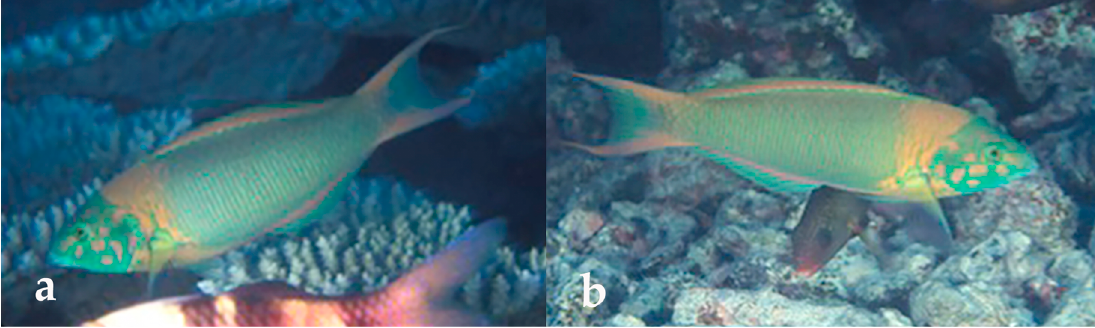
Figure 4. A single Thalassoma duperrey X lutescens hybrid showing it’s left ( a ) and right ( b ) sides.